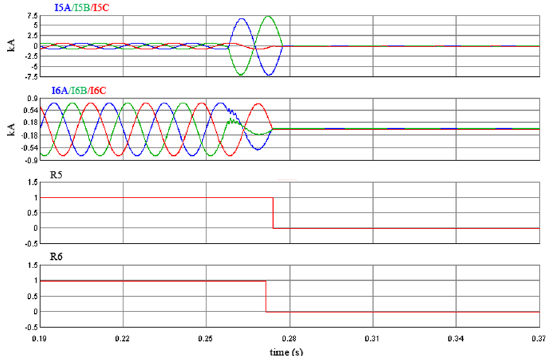
Table 7 Average operation time under different fault conditions Fault type